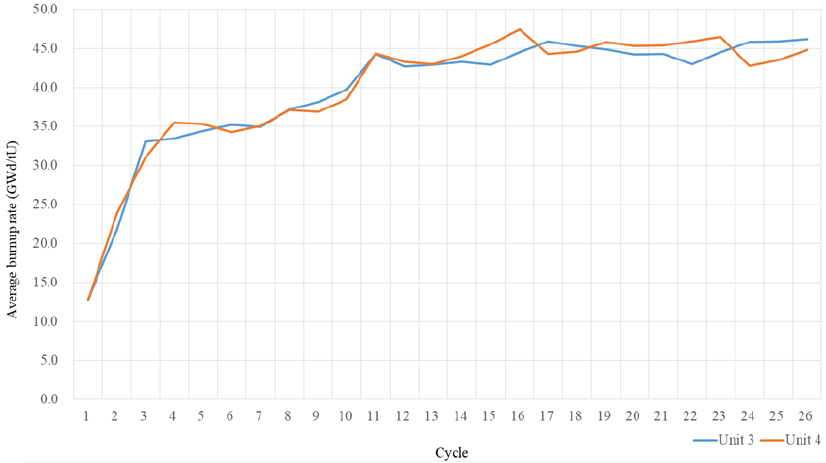
Figure 1 . Average burnup rate trend of spent nuclear fuels of Kori units 3 and 4. Figure 2. Average burnup rate trend of spent nuclear fuels of Kori units 3 and